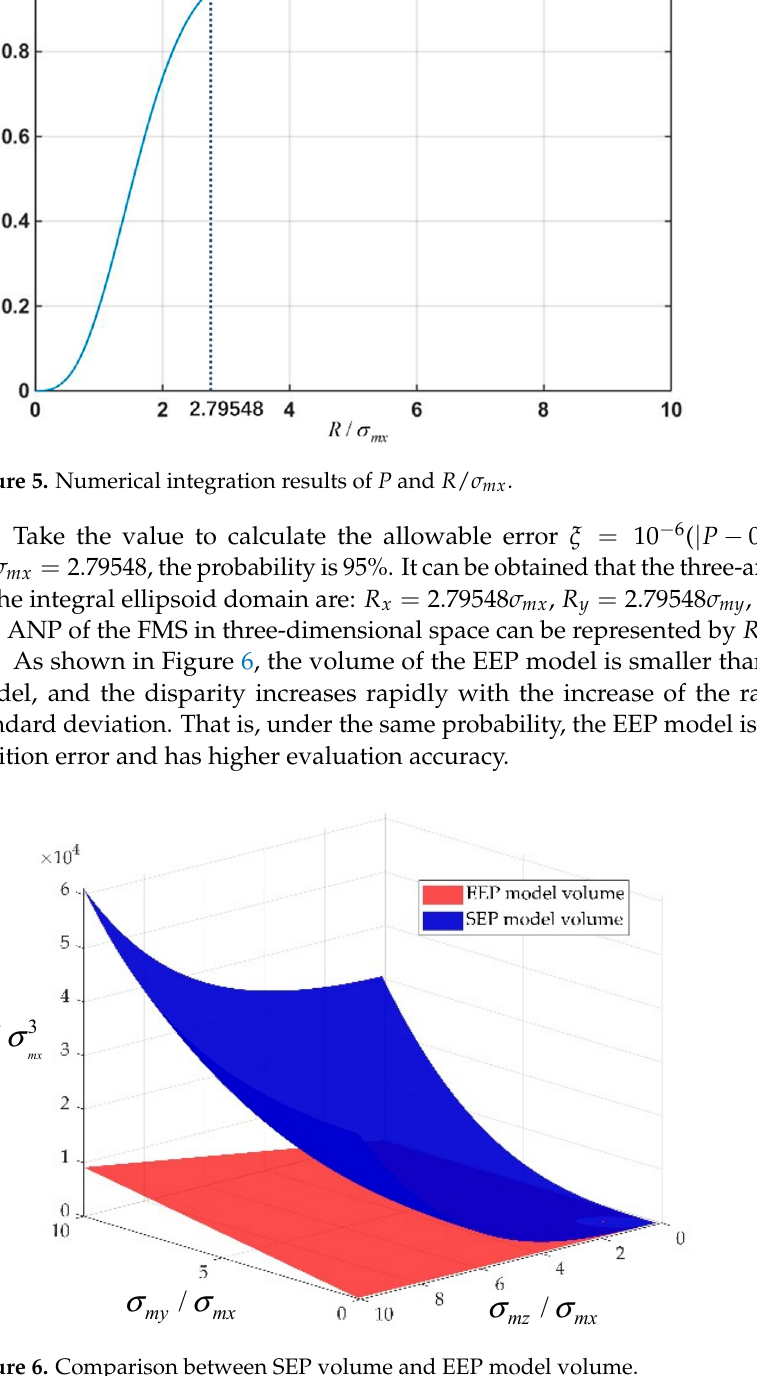
Figure 7. Comparison between EEP model and SEP model in XOY plane. Figure 8. Comparison between EEP model and SEP model in XOZ plane.